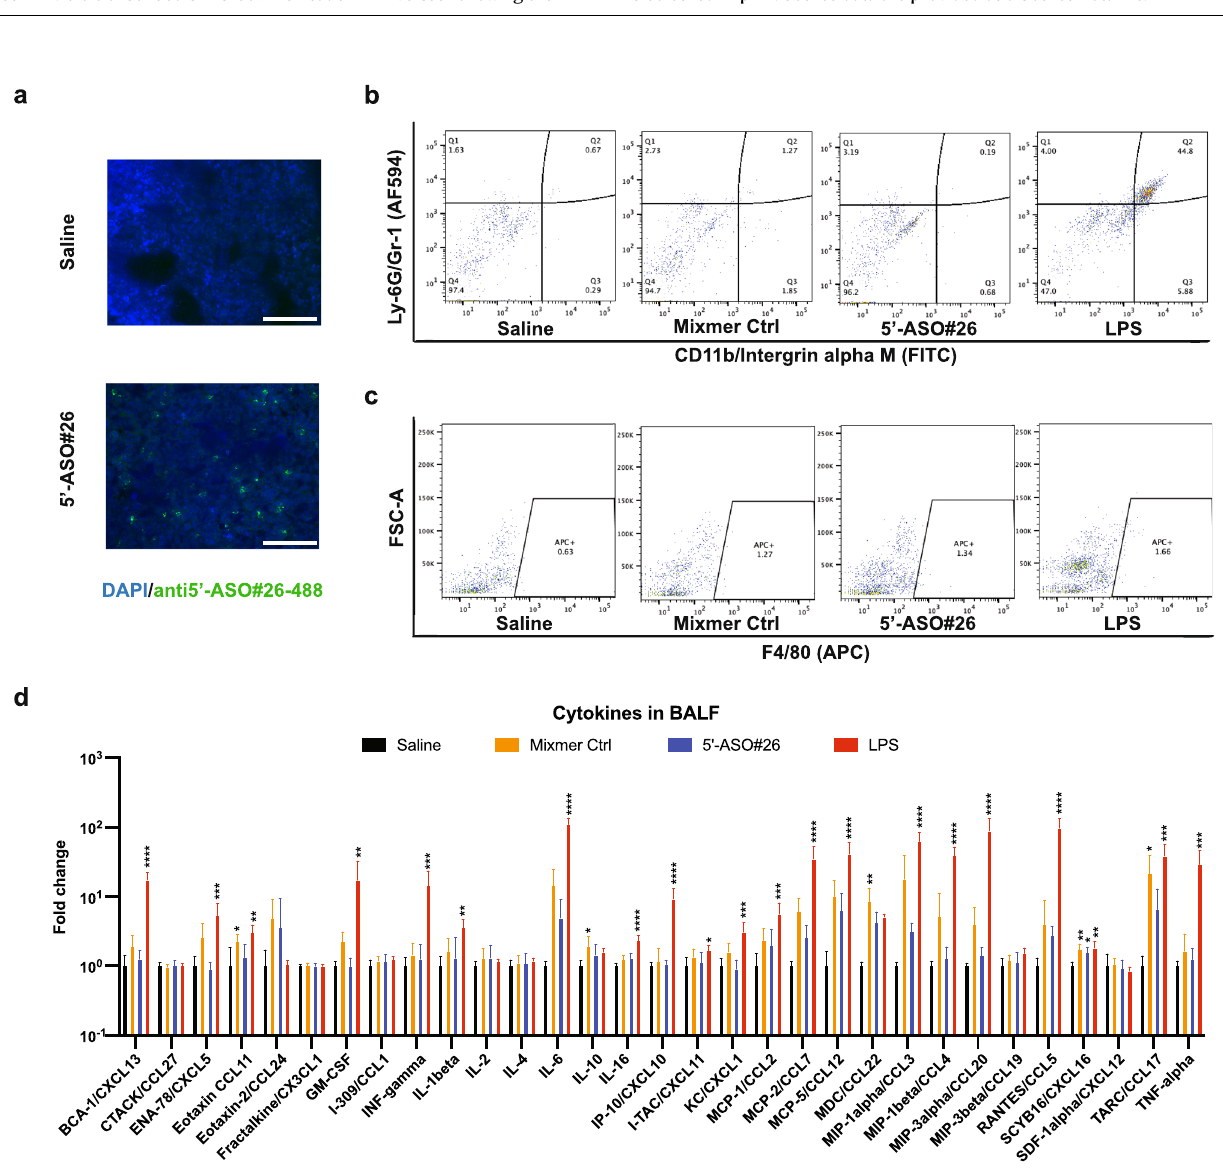
Fig.2|5 ’ -ASO#26disruptsstemloop1(SL1)ofSARS-CoV-2.a Structuralmodelof SL1-4predictedfromtheDMS-MaPseqofinvitro-transcribed5 ’ leaderRNAwiththe addition of control LNA ASO (left) and 5 ’ -ASO#26 (right). Nucleotides are color- coded by normalized DMS signal. The 5 ’ -ASO#26- sequence is shown in magenta and the binding site on the viral genome is highlighted with a pink frame; PCR primer binding site, where DMS information is unavailable, is highlighted with a grey frame. b Per-nucleotide-difference in DMS reactivity ( Δ DMS reactivity) between in vitro-transcribed SARS-CoV-2 5 ’ -leader RNA versus following the